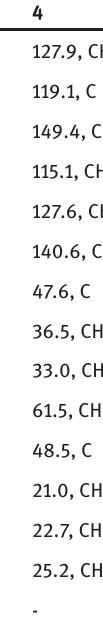
Table 2: 13 C NMR data of compounds 1 ‒ 4 (CDCl